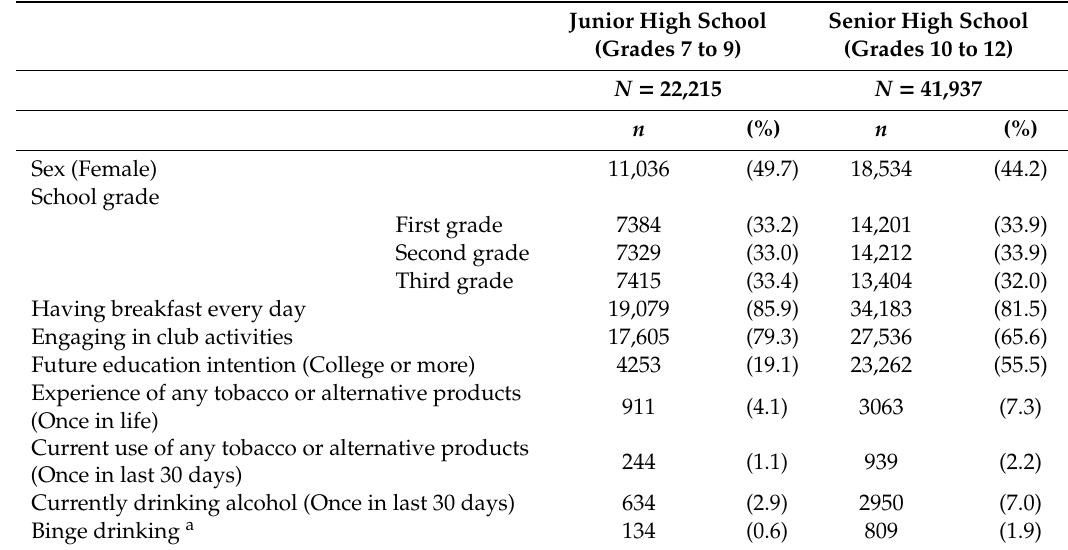
Table 1. Baseline characteristics of the study participants.